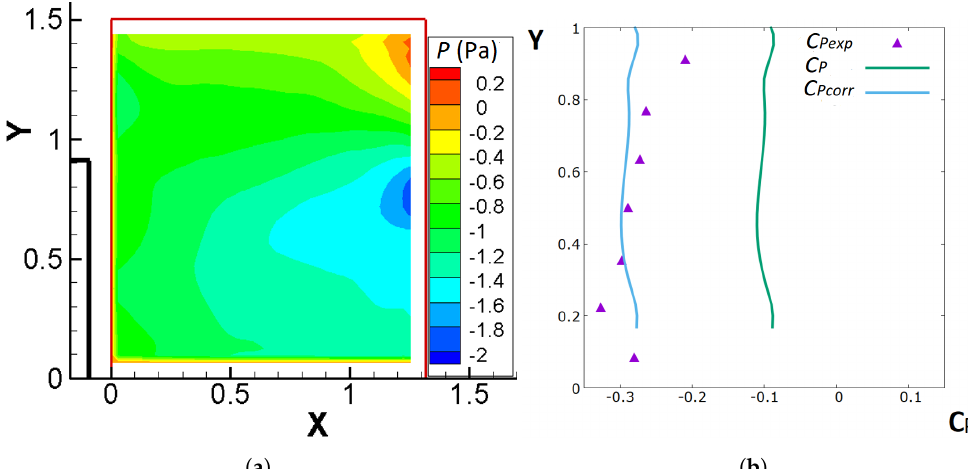
Figure 16. ( a ) Pressure contours, P (Pa), on plane C. ( b ) Comparison between C P centre line of the downstream wall of the cube, where the Y-axis corresponds to the non-dimensional distance from the south boundary of the PIV domain ( Y = 0.91 denotes the upper edge of the cube). Flow is from left to right in ( a ) (Adapted with permission from Ref.